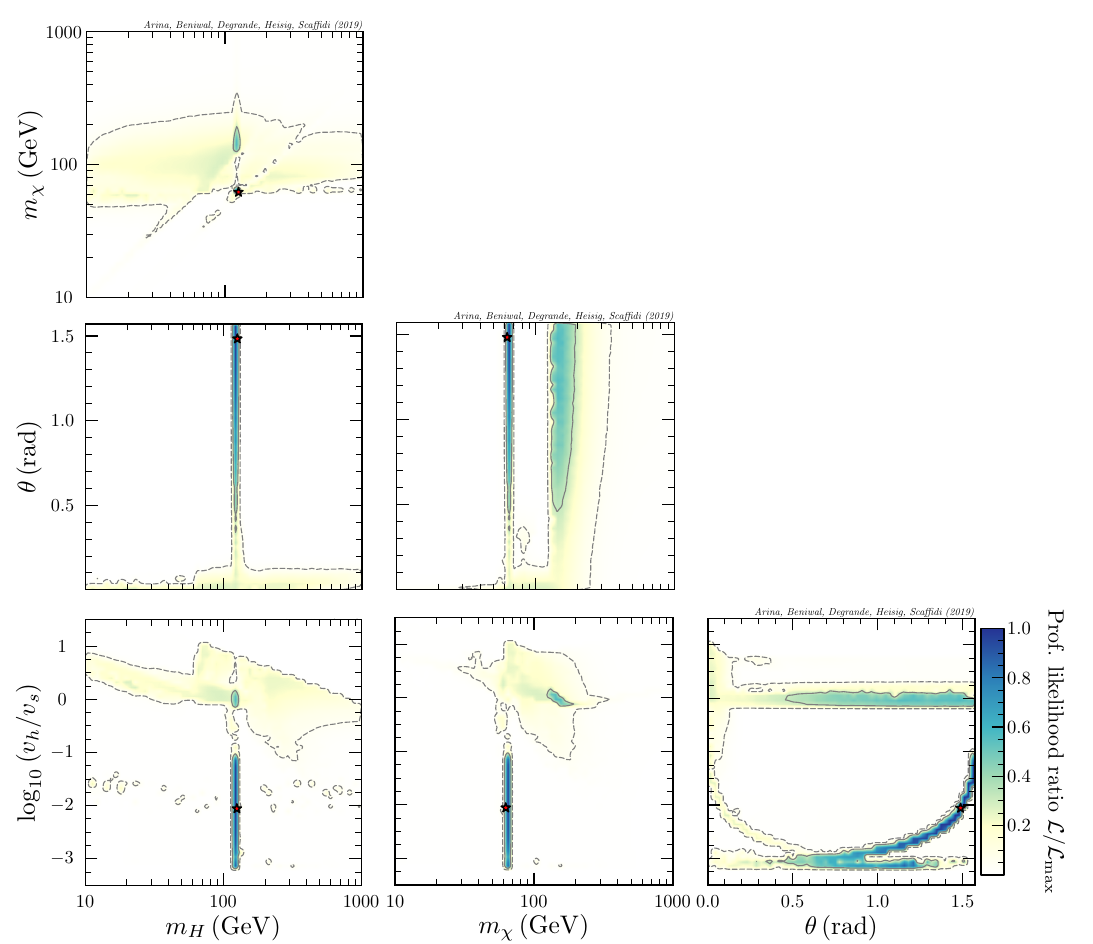
Figure 8 . 2D PLR plots for the pNG DM model parameters after post-processing our samples with Fermi -LAT likelihood from 45